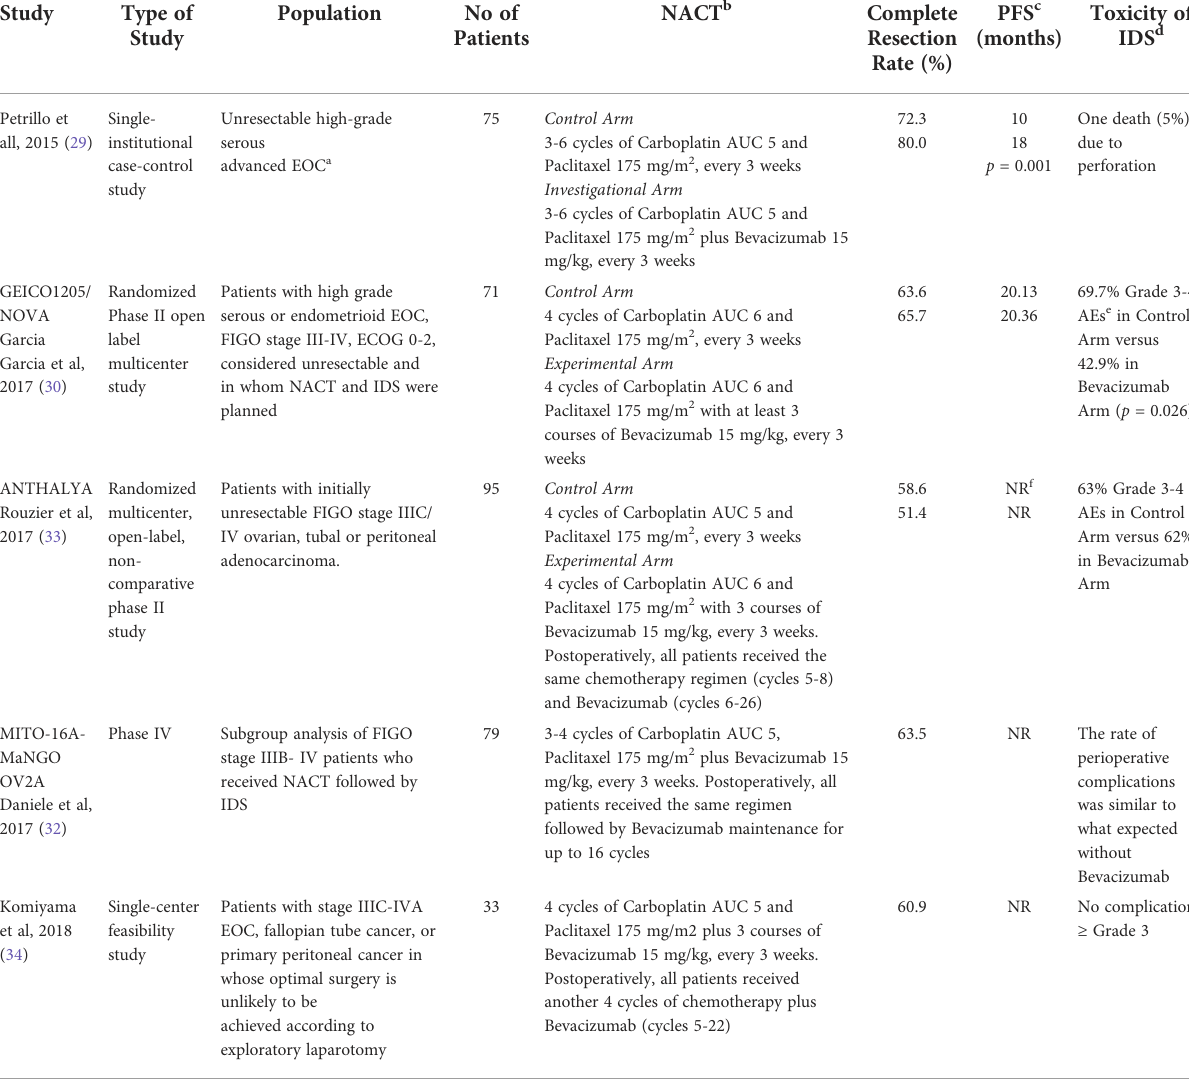
TABLE 3 Studies that evaluated the incorporation of bevacizumab into the neoadjuvant treatment of advanced epithelial ovarian cancer.